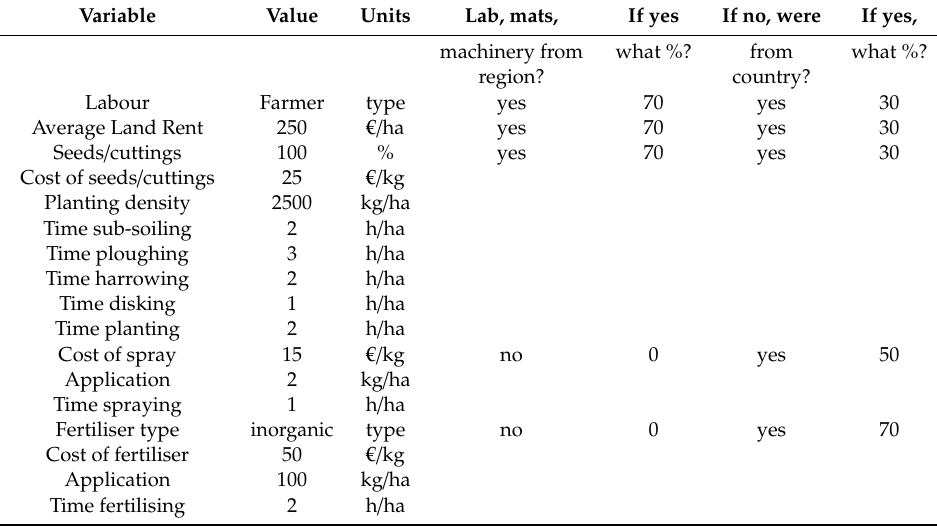
Table A1. Feedstock production data: Crop establishment.